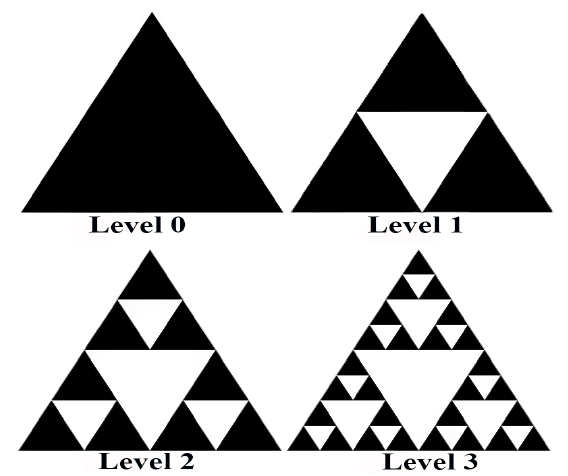
Figure 2. Levels of Sierpinski triangles